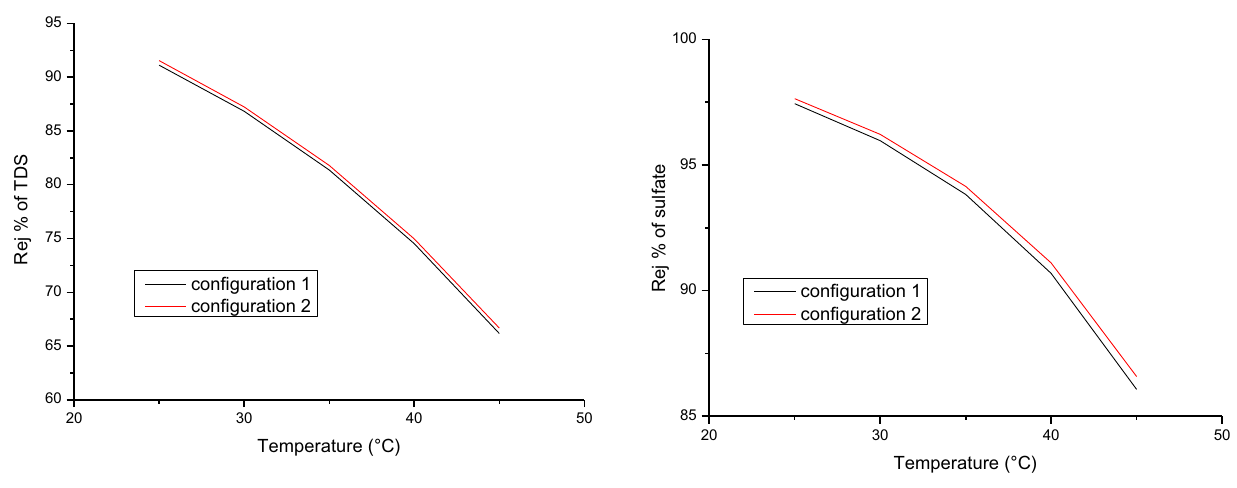
Fig. 17 Comparison between conf a and conf b on sulfate removal % at optimum feed